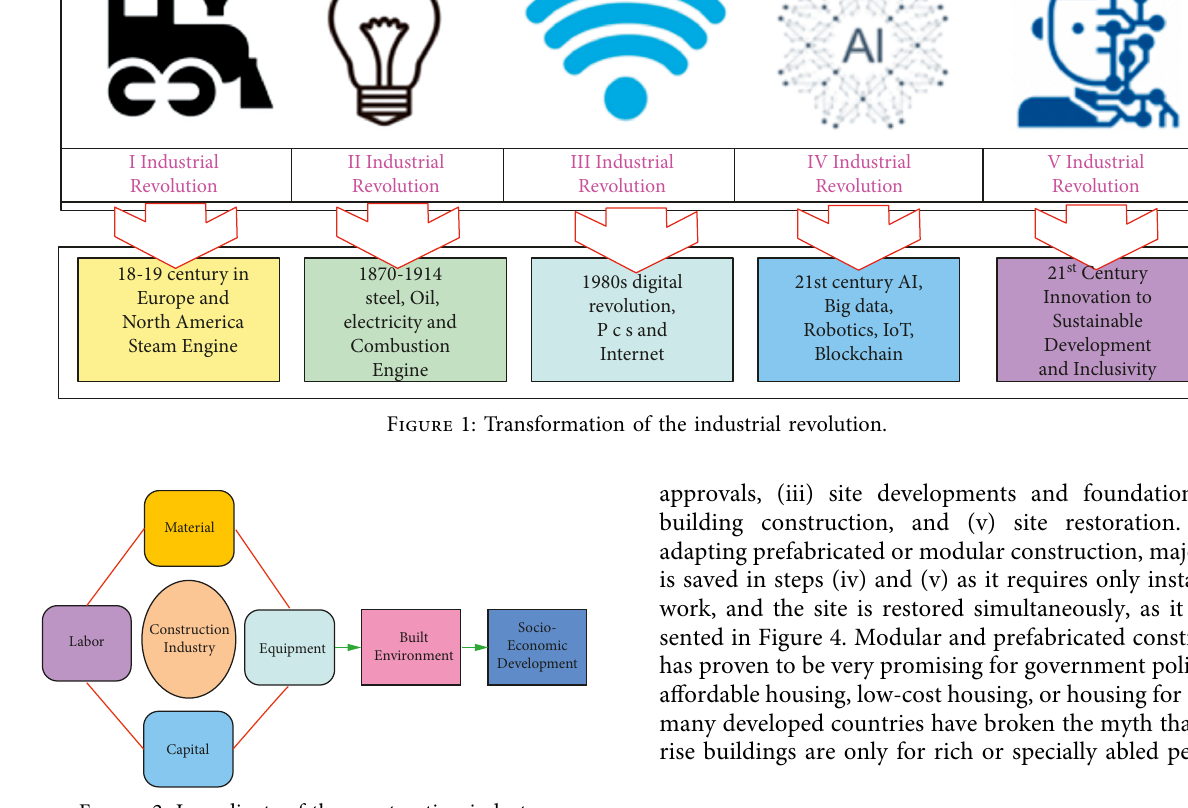
Figure 2: Ingredients of the construction industry.